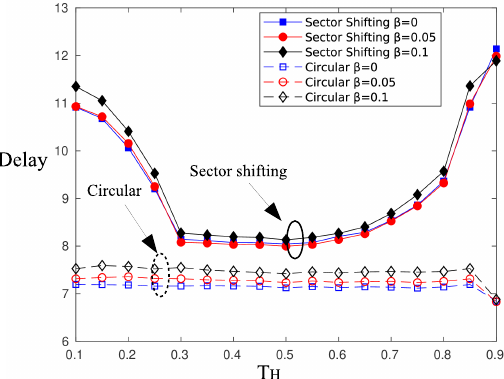
Figure 19. Delay of information reception using the sector shifting